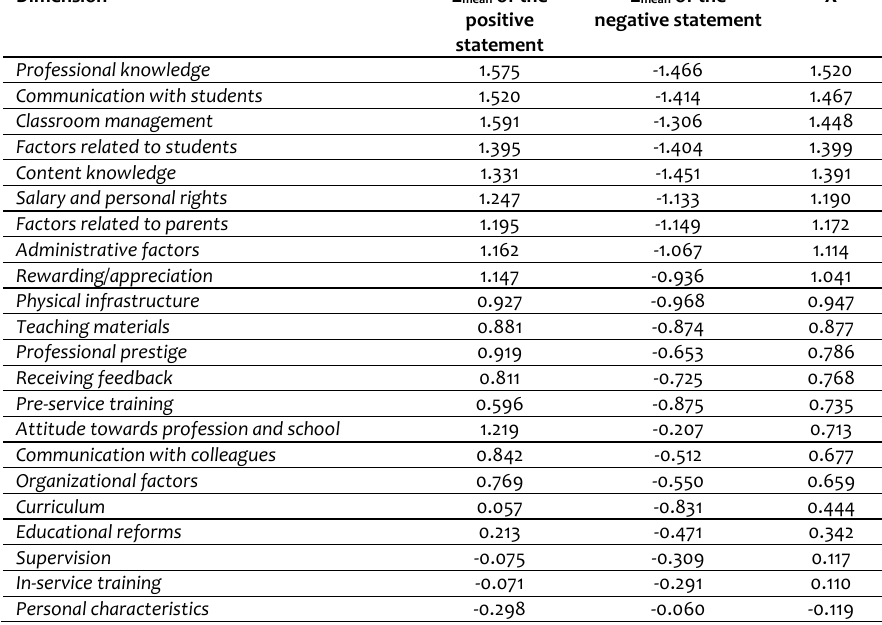
Table 10. Z-values related to the factors affecting teachers’ performance